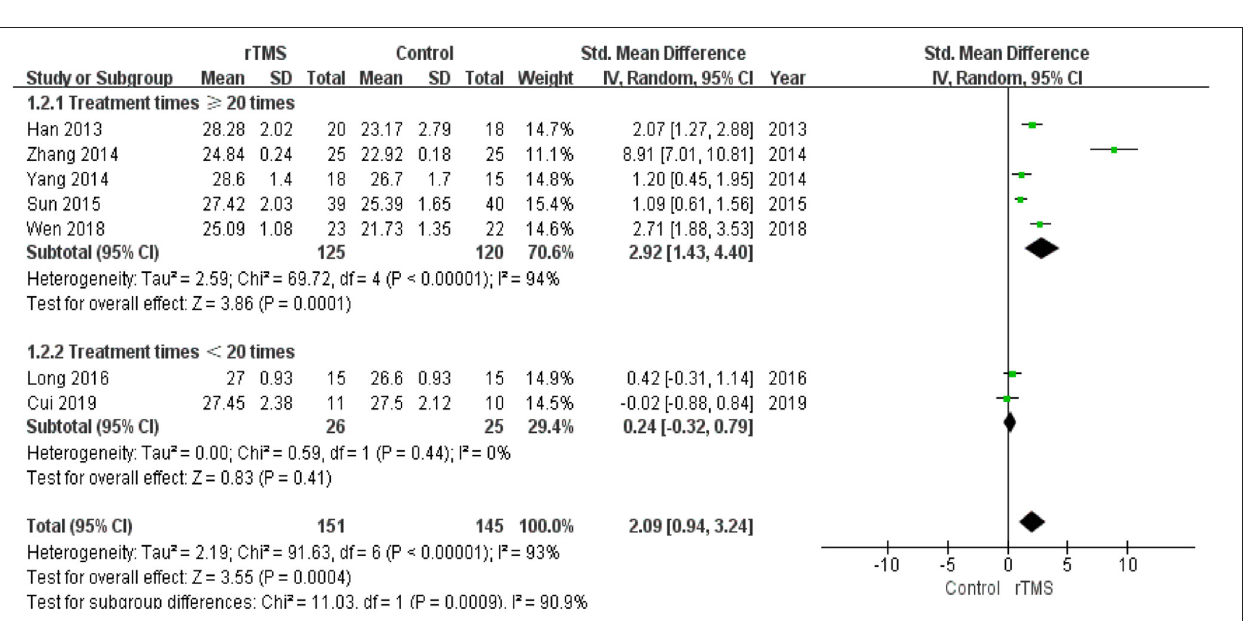
FIGURE 6 | Meta-analysis forest plot of subgroup analysis showing global cognitive function of repetitive transcranial magnetic stimulation group vs. control group in the treatment of mild cognitive impairment: treatment times ≥ 20 times vs. treatment times < 20 times.